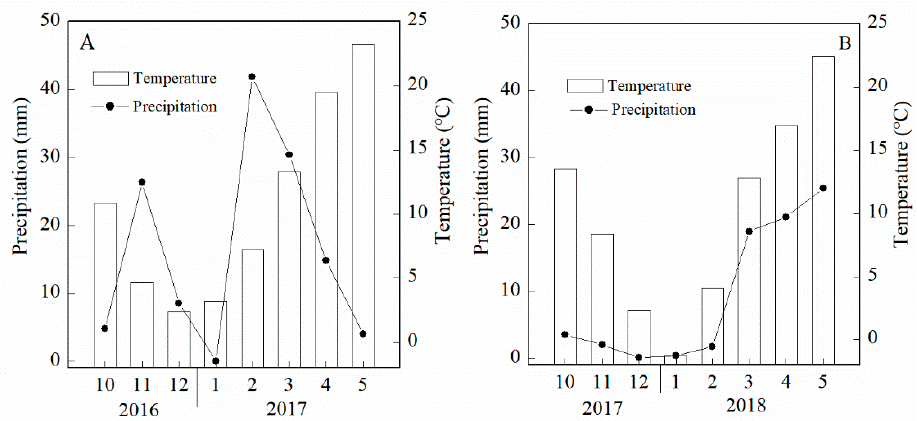
Figure 1. The average precipitation and temperature during the wheat growing seasons in experimental fields: ( A ) 2016–2017, ( B ) 2017–2018. fields: ( A ) 2016–2017, ( B )